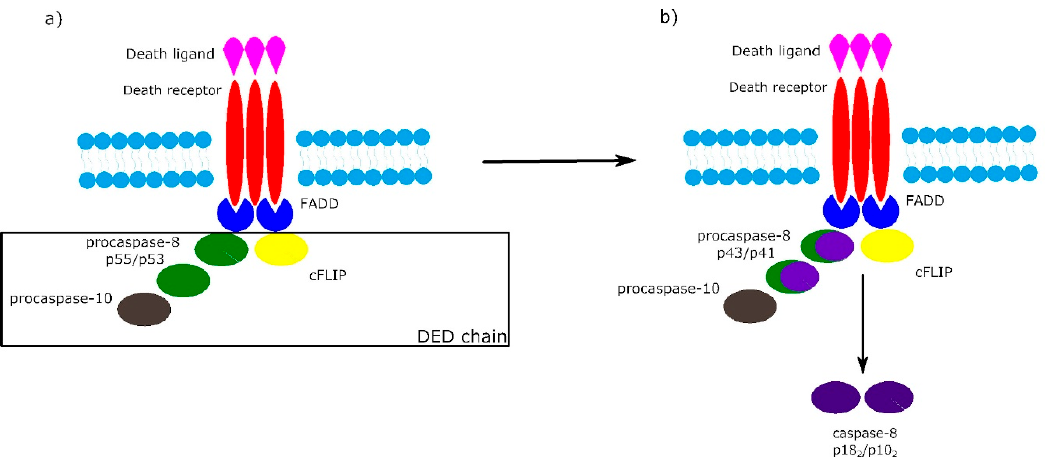
Figure 2. Death e ff ector domain (DED) chains and procaspase-8 transprocessing. ( a ) Activation of procaspase-8 begins with DED chains, which consist of procaspase-8 p55 / p53, procaspase-10 and c-FLIP. ( b ) Procaspase-8 homodimers are converted into active caspase-8 heterotetramers p18 2 / p10 2 via the intermediate procaspase-8 p43 / p41.